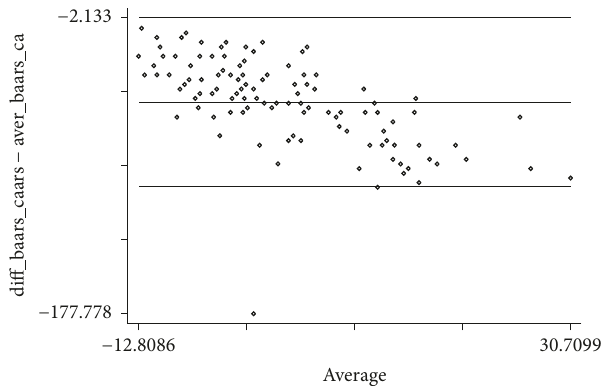
Figure 3: A Bland-Altman plot for agreement between the BAARS- IV and CAARS-S: SV